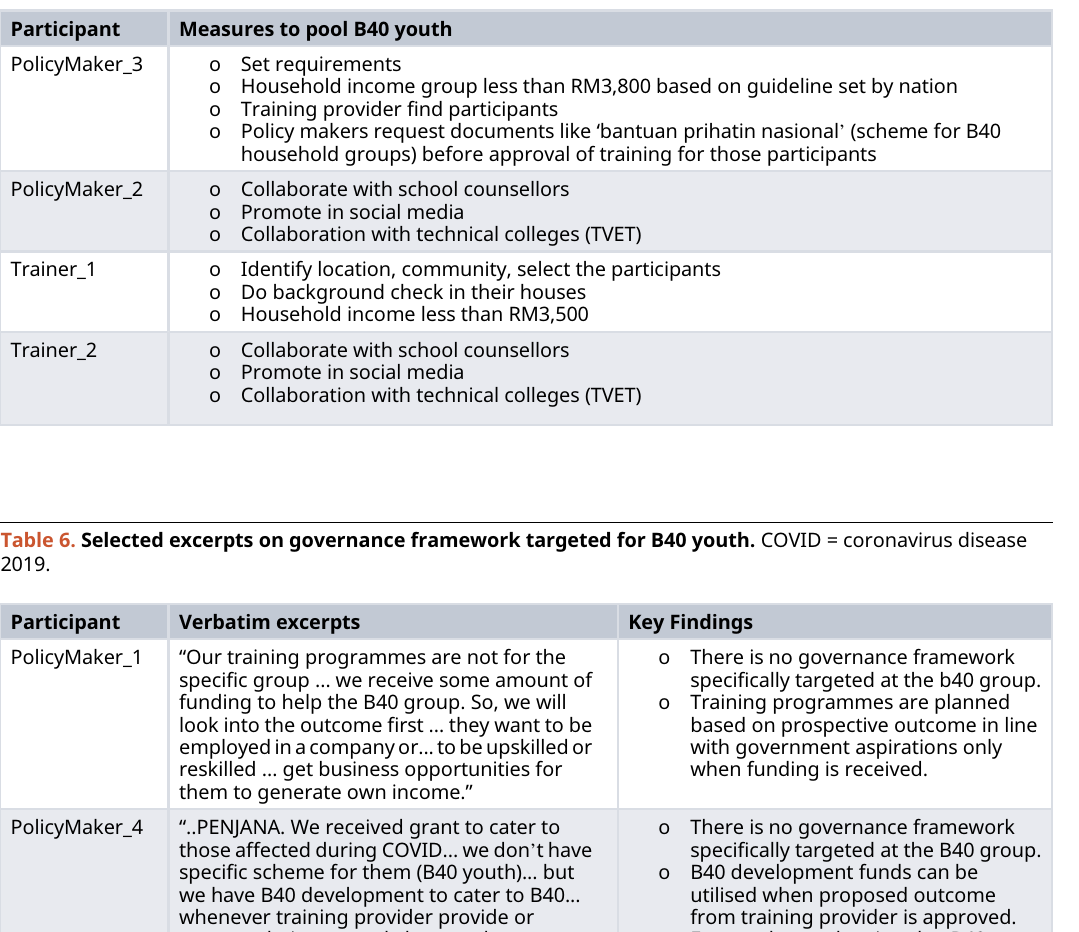
Table 5. Measures to identify and pool B40 youth for training.